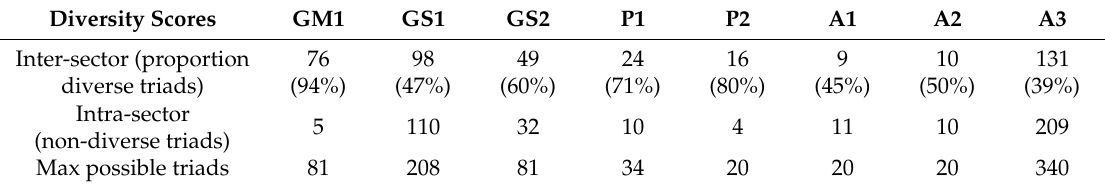
Table 4. Diversity: count of diverse triads in the observed ego-centric networks.